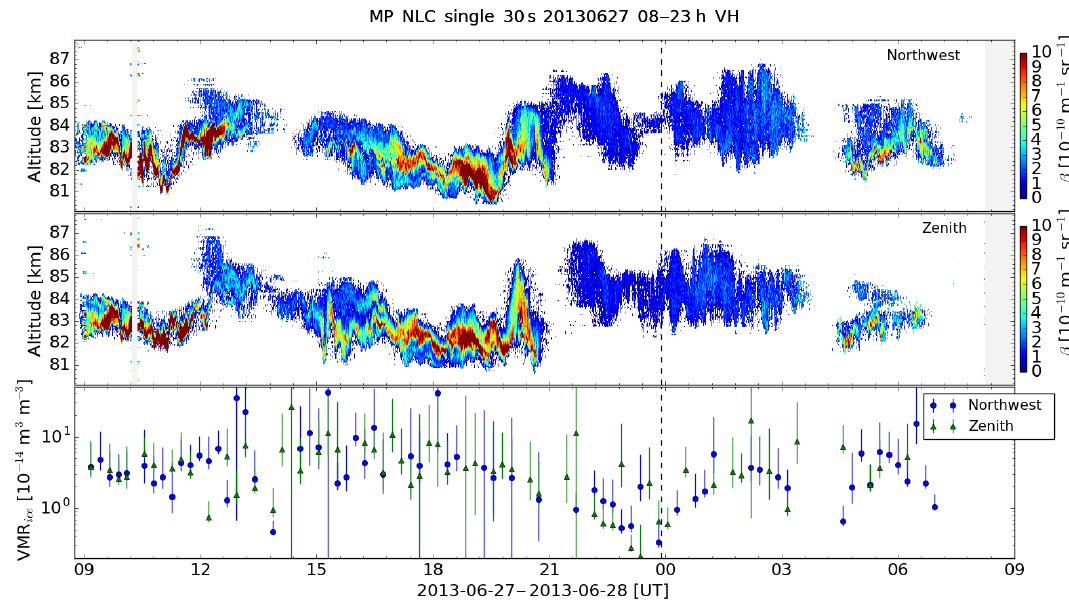
Figure 5. NLC observations by the RMR lidar. The vertical line marks the WADIS-1 launch.